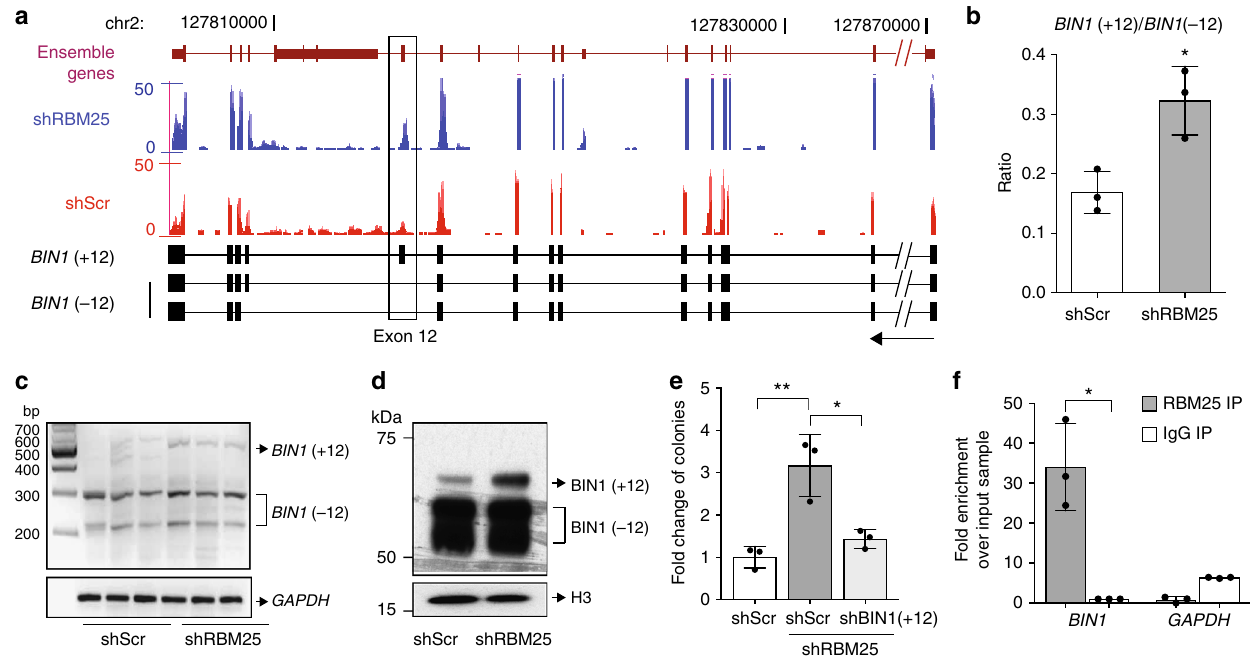
Fig. 6 RBM25 knockdown affects alternative splicing of the BIN1 pre-mRNA. a Genome browser tracks showing RNA-seq reads coverage across the BIN1 locus in shScr control (red) and RBM25 KD (blue) U937 cells (upper panel). Lower panel illustrates three alternatively spliced isoforms of the BIN1 pre- mRNA. The black rectangle highlights the BIN1 exon 12. b − d RBM25 KD alters the relative usage of BIN1 isoforms as assessed by b RNA-seq, c semi- quantitative RT-PCR, and d western blot analyses. e Partial rescue of the increased colony-forming capacity of RBM25 KD cells by speci fi c KD of BIN1( + 12). f RNA immunoprecipitation (RIP) demonstrating speci fi c binding of RBM25 to BIN1 mRNA. Bar graphs in ( b ), ( e ) and ( f ) represent the mean ± s.d., n = 3, and P values were determined by t test. * P < 0.05, ** P < 0.01. Panels ( b ), ( d ) and ( f ) show representative results of ≥ 2 independent experiments. All replicates in ( b ), ( c ), ( e ) and ( f ) are biological